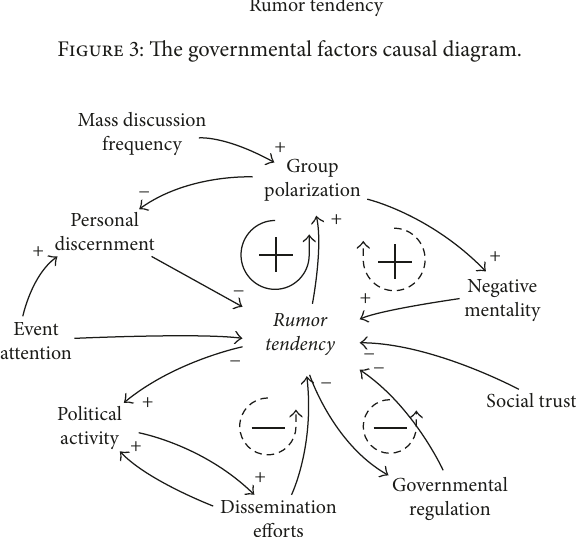
Figure 4: Thedisinformation behavior drivers causal-loop